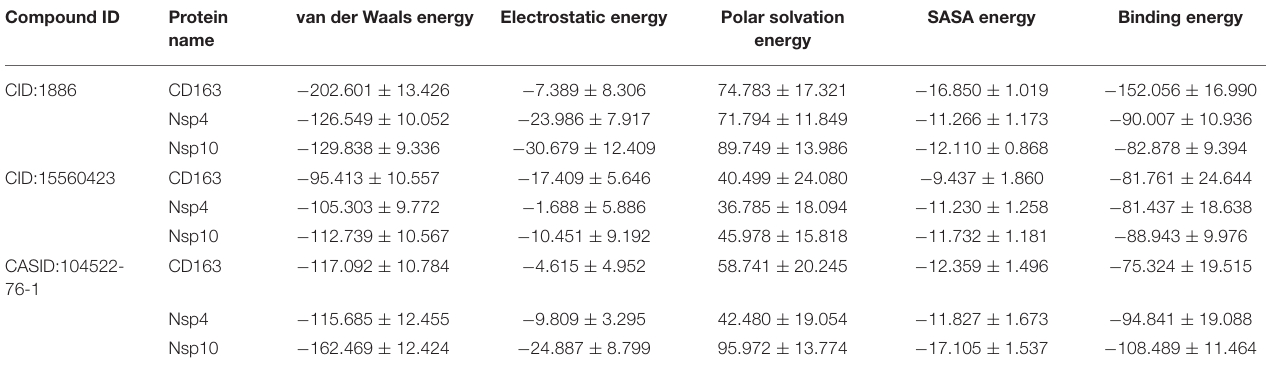
TABLE 3 | Affinities of multi-target neem phytochemical compounds with CD163-SRCR5, Nsp4, and Nsp10 (van der Waals and electrostatic forces, polar solvation, SASA, and binding free energy in kJ mol − 1 ). Compound ID Binding